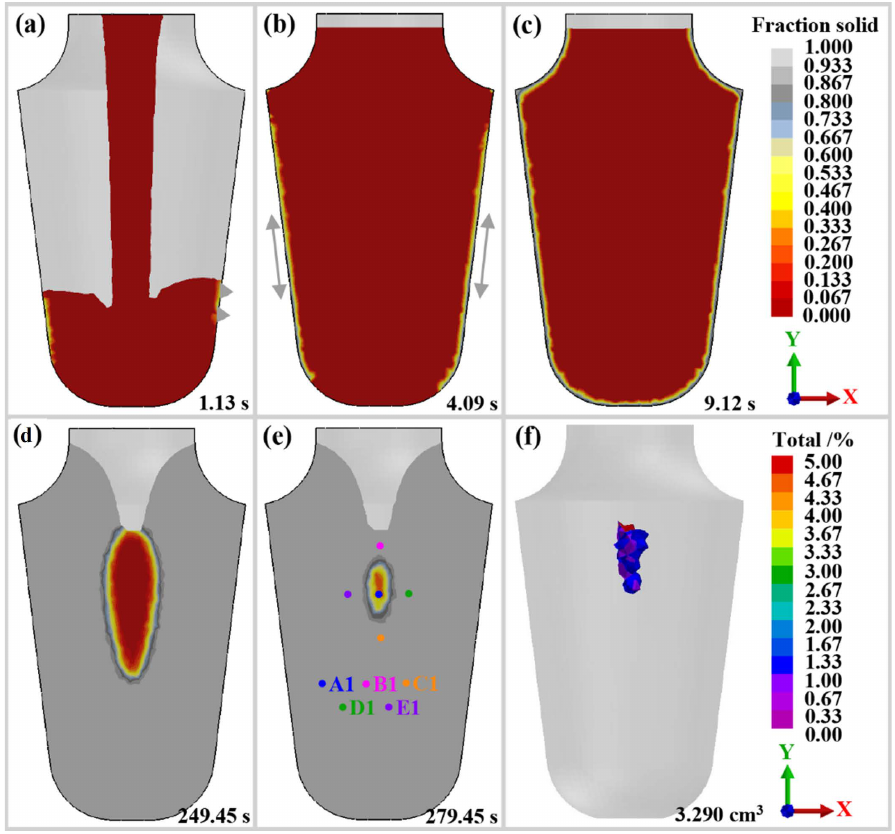
Figure 3. Solidification process ( a – e ) and shrinkage porosity ( f ) of Ti-6Al-4V alloy in mold